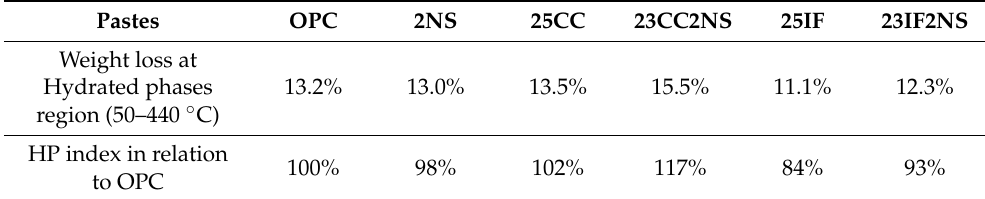
Table 4. Weight loss related to HP index for the pastes at 28